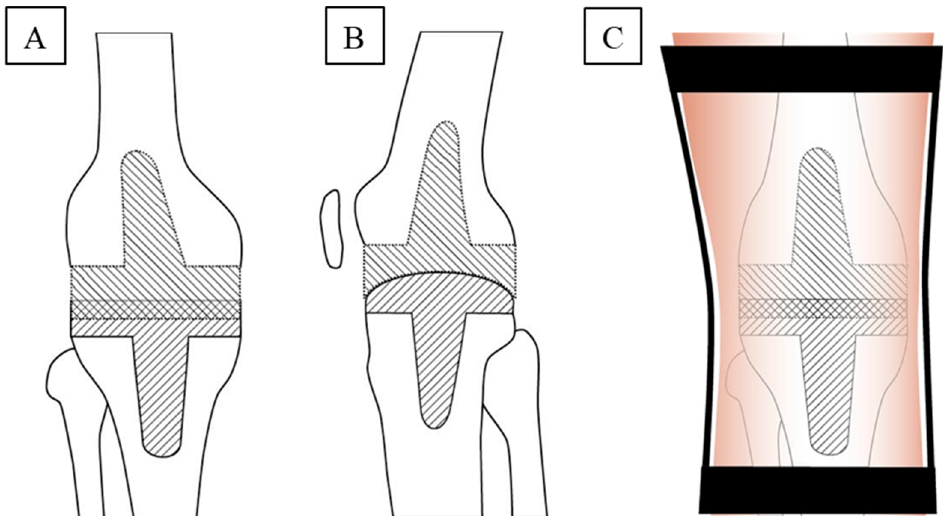
Figure 1. Spacer design and mechanical conditions during post-operative mobilization of the patient . ( A ) Anterior to posterior and ( B ) lateral, schematic design of the inverse spacer, consisting of convex tibial and concave femoral components, each equipped with a stem component to ensure optimal anchoring in the medullary canal for rotational stability; ( C ) application of a straight leg brace to prevent medio-lateral knee movement and strongly limit knee flexion. The spacer design combines the following features: (i) tight embracing of the convex tibial part by the concave femoral part in a hinge-like joint sufficiently prevents anterior to posterior spacer translation; (ii) smaller bone defect, anatomic shape, and a levelled, broad weight-bearing surface suggested a convex tibia component, a larger, anatomically concave femur defect with a central notch suggested a concave femoral component; (iii) successive molding/polymerization of the tibial and femoral components under maximal tension allowed adaptation of the two components with minimized play.